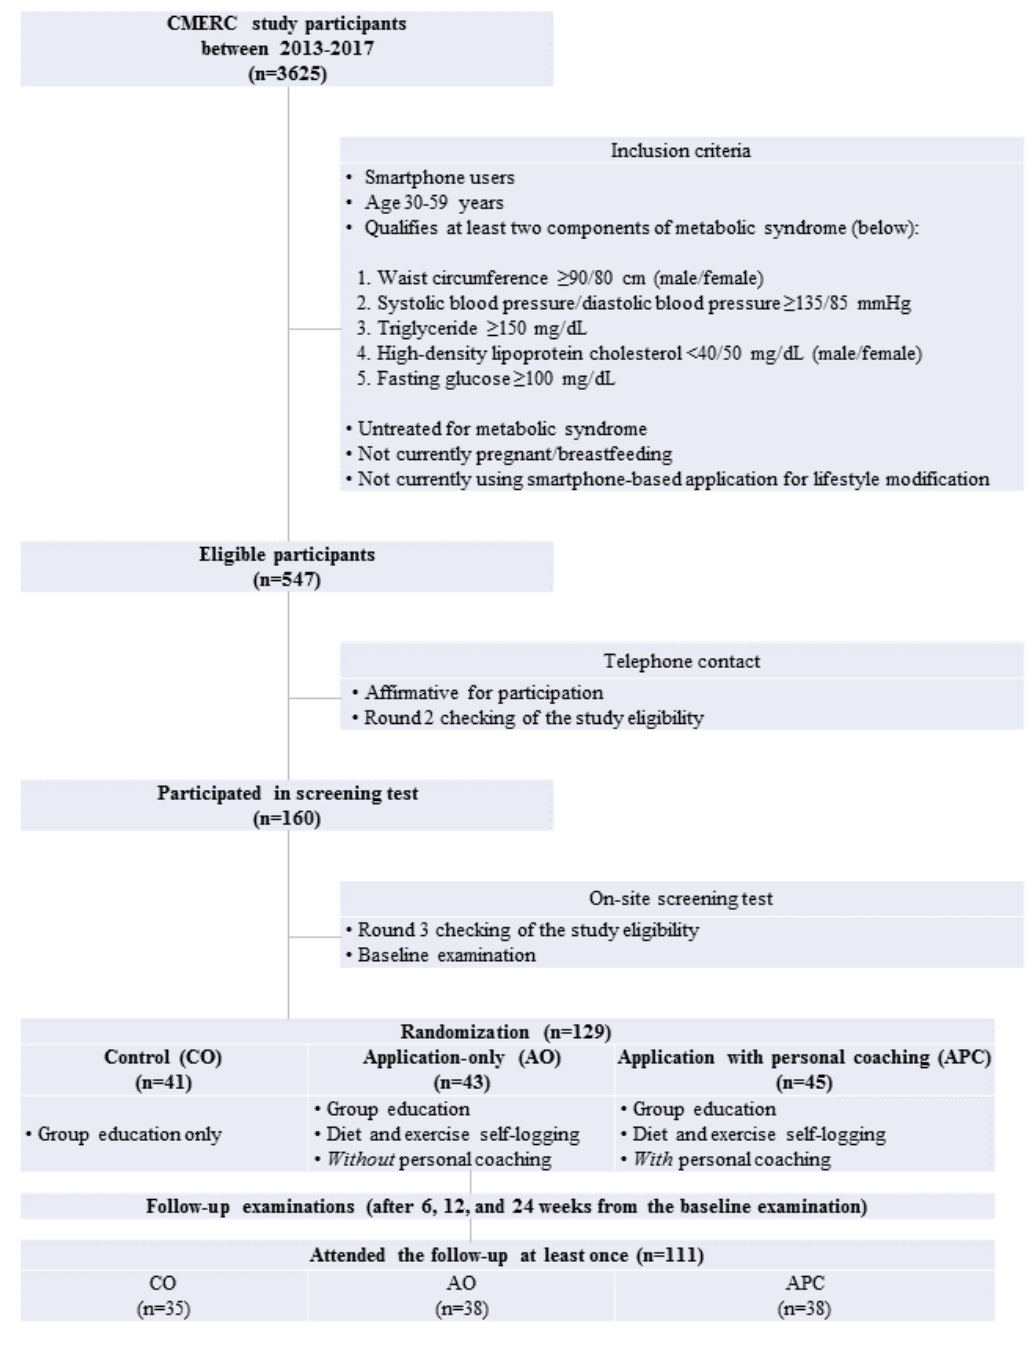
Figure 1. Flow diagram of the study participants. CMERC: Cardiovascular and Metabolic Diseases Etiology Research